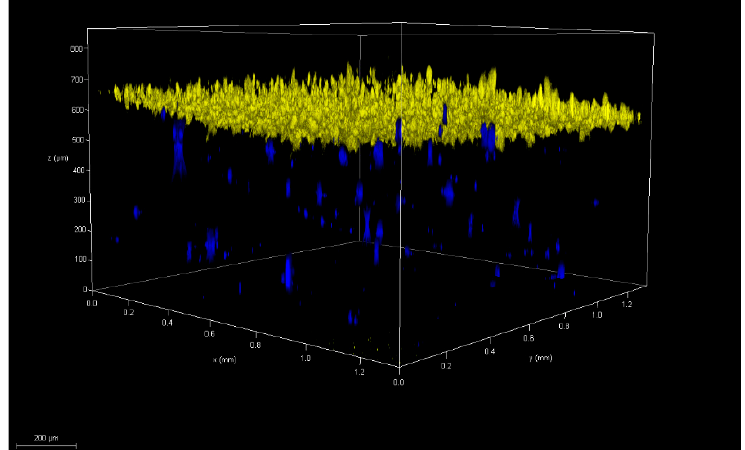
Figure 3. Skin model recapitulating full skin thickness with labeled epidermal layer formed by HaCat cells on top (yellow) and labeled dermal layer formed by primary dermal fibroblast (blue) below within a microfluidic device.